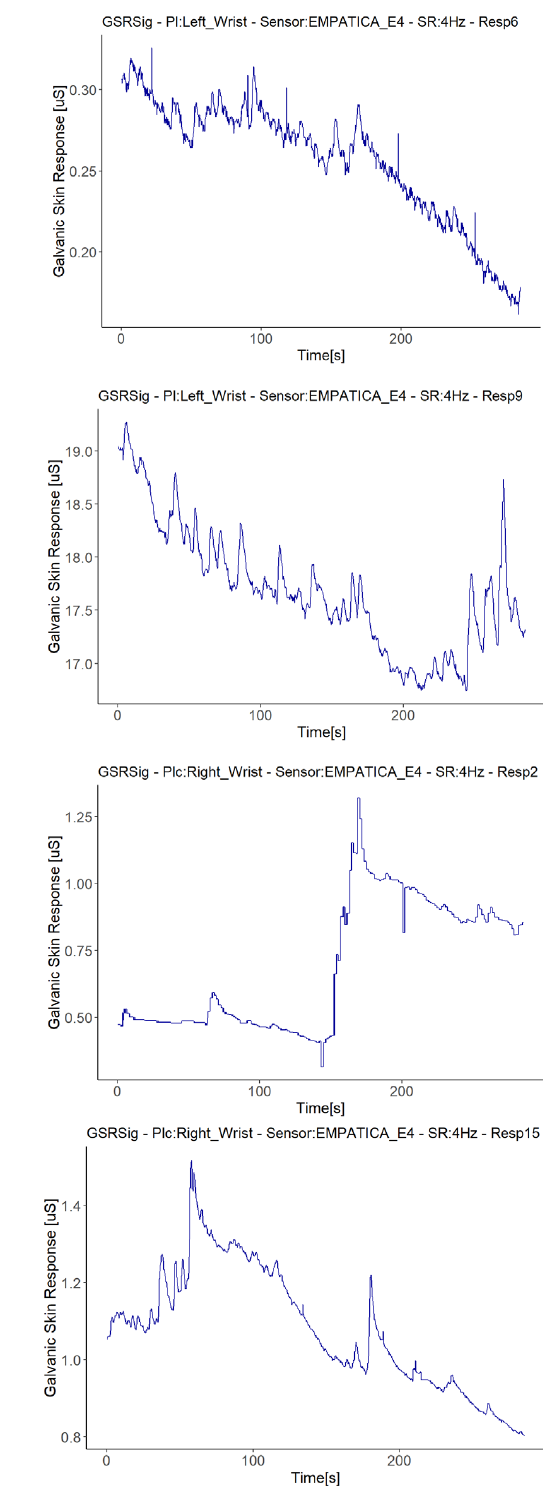
Figure 11. Illustration of cases with fall to zero anomalies detected. On the left are the signals with anomalies, while on the right are the other signals measured in the same respondent with the same sensor type.